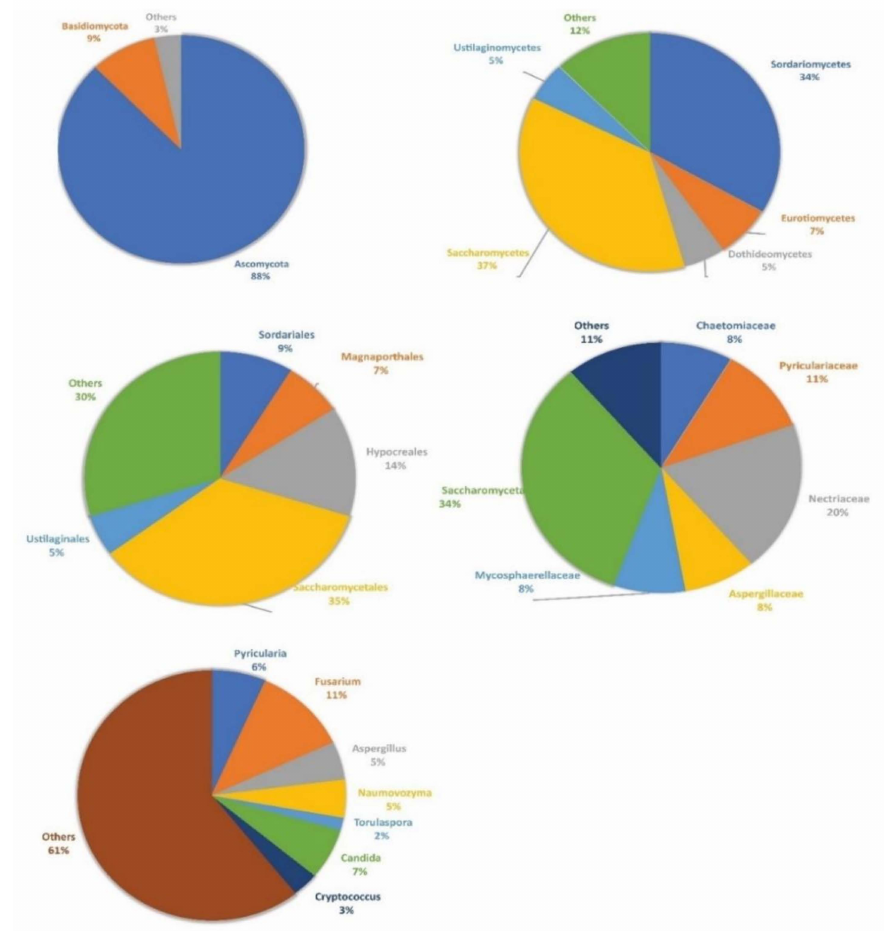
Figure 4. Abundance of various fungal phyla, order, group, genus, and family present in ZBNF soil. Fusarium, Aspergillus, Pyricularia , etc., were observed as major genera contributing to the ZBNF soil. All these genera are known fungal decomposers, which decompose the dead decaying matter and improve the soil